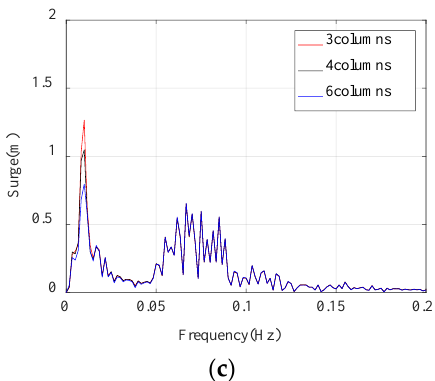
Figure 12. Surge response spectrum for the three platforms under wave loadings ( a ) LC4, ( b ) LC5, and ( c ) LC6.